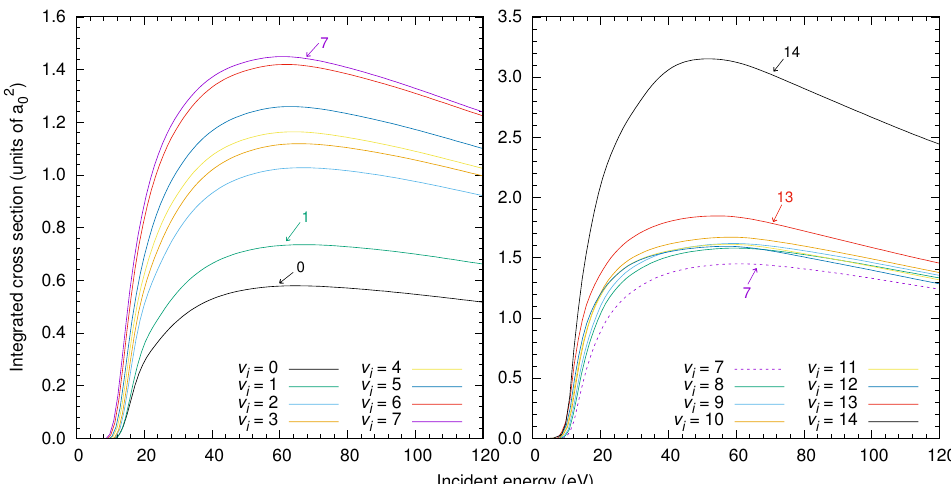
Figure 3. Electron-impact cross sections for dissociation of the v i = 0–14 vibrational levels of the X 1 Σ + g state through the singlet spectrum of H 2 .